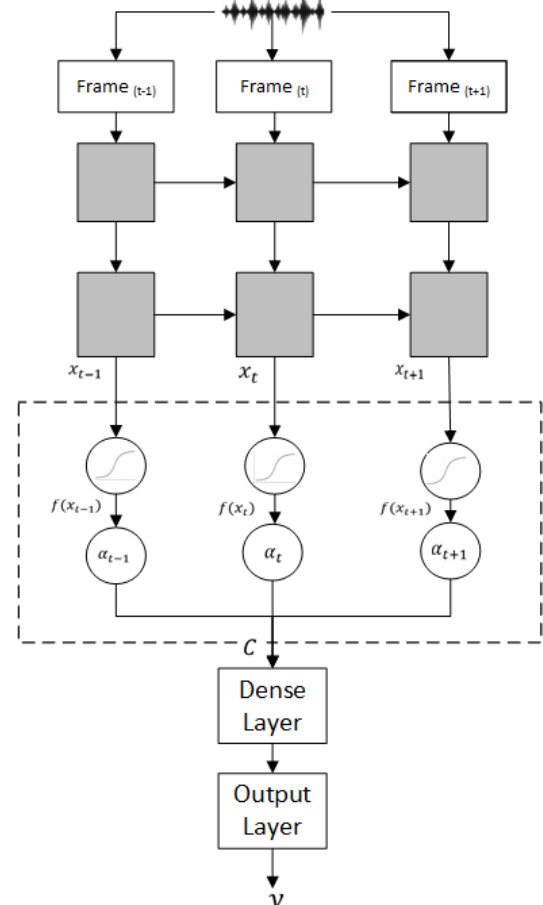
Figure 2. The role of the attention